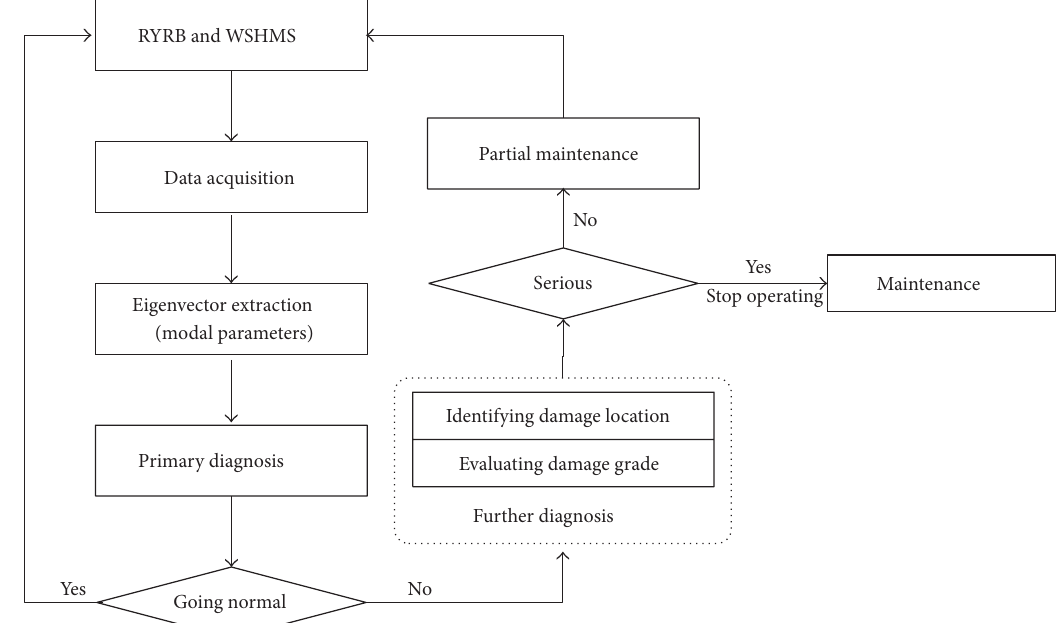
Figure 14: Condition identification strategy of RYRB.